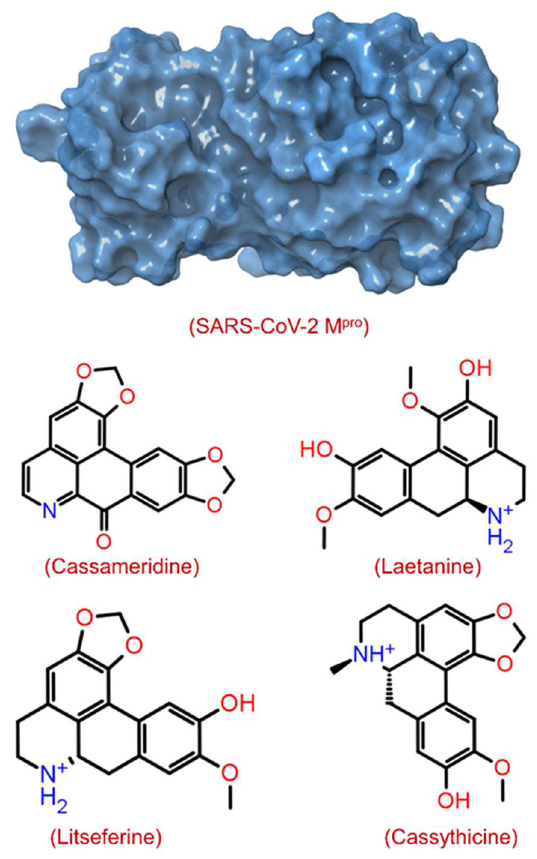
Figure 1 . Structure of SARS-CoV-2 M pro with 3D surface exhibiting various pockets and 2D chemical diagram for screened potential compounds as inhibitor of SARS-CoV-2 M pro . The binding energy observed for cassameridine, laetanine, litseferine and cassythicine, were − 9.3, − 8.8, − 8.6, and − 8.6 kcal/mol (Tables 1 and S1) , respectively. However, in a re- cent study, doxycycline and minocycline antibiotics have been shown as potential inhibitor against SARS-CoV-2 M pro with binding energy of > − 7 kcal/mol [42]. In an in silico, the binding energy observed for Withanoside V, a natural compound from Withania somnifera , against SARS-CoV-2 M pro was − 8.96 Kcal/mol [22]. The binding energies observed in the above studies are higher than in the present